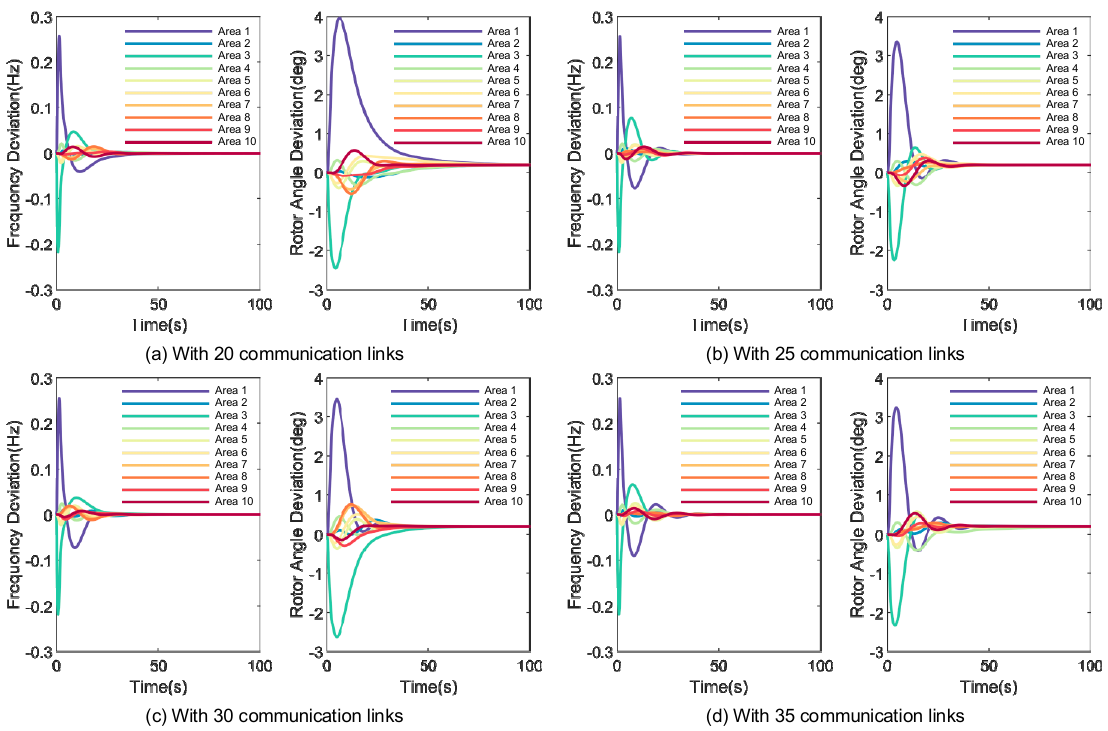
Figure 14. Frequency deviation and rotor angle deviation of the proposed method and the compared method with different numbers of communication links in frequency event H.